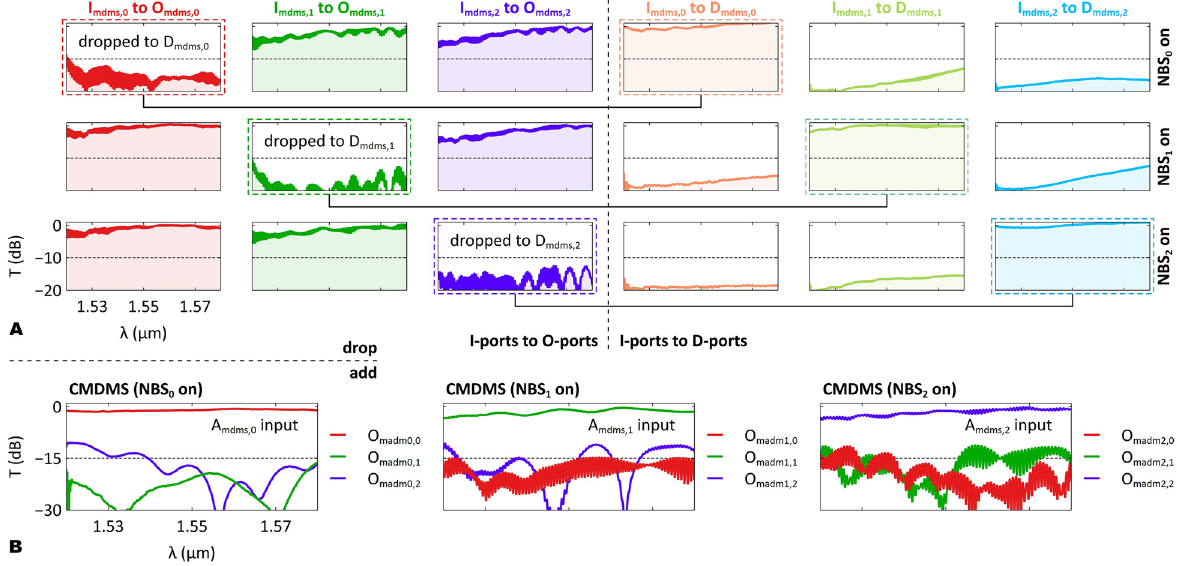
Figure 6: Add-drop operation results for direct-access mode-division multiplexing switches (MDMS). (A) The measured transmittance spectra at output ports (left penal) and dropping ports (right panel) as light is launched from input ports and NBS 0-2 wereswitchedon.Thedashedboxeshighlightdroppedmodecarriers.(B)Themeasuredtransmittancespectraat outputportsas light was launched from adding ports while NBS 0-2 were switched on. CMDMS, cascaded mode-division multiplexing switch; NBS, normally-bar